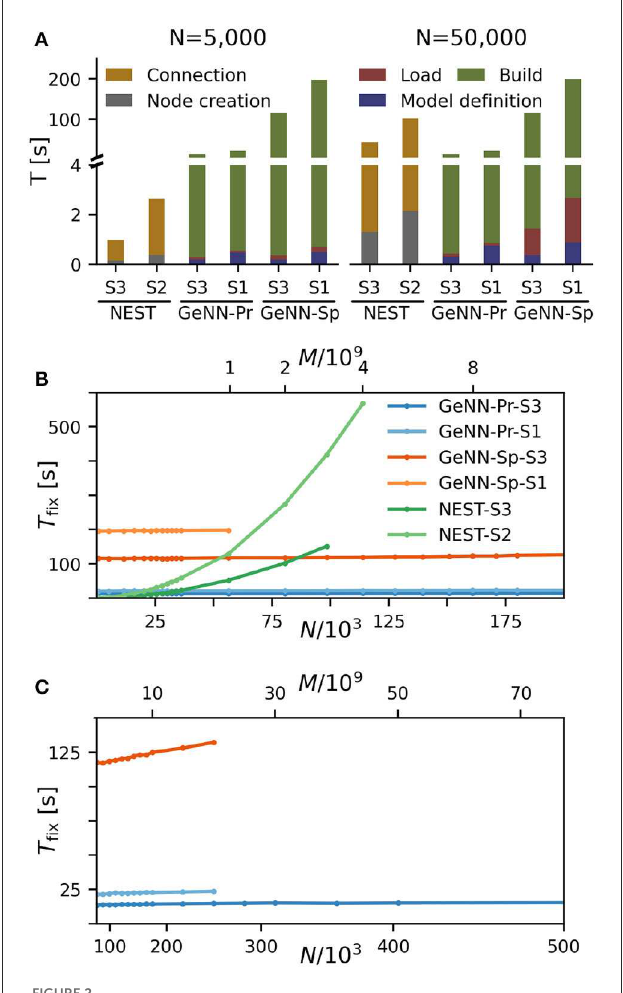
FIGURE2 Fixed costs of simulation. (A) Individual costs for execution phases of NEST and GeNN for two network sizes of N = 5,000 and N = 50,000 neurons. The GPU-based simulation requires expensive model compilation (Build). NEST uses pre-compiled neuron models. Note that the y-axis has different linear scales for low ( ≤ 4) and high ( ≥ 4) values of fixed costs. (B, C) Total fixed costs in seconds over network size for the different simulators and hardware configurations as indicated. Total fixed costs are approximately constant across network size for the GPU-based simulation with the PROCEDURAL connectivity, while they have a small slope for the SPARSE connectivity. (C) Extends (B) for larger network sizes. Note that the x-axis in (B) is linear in N , while the x-axis in (C) is linear in M .